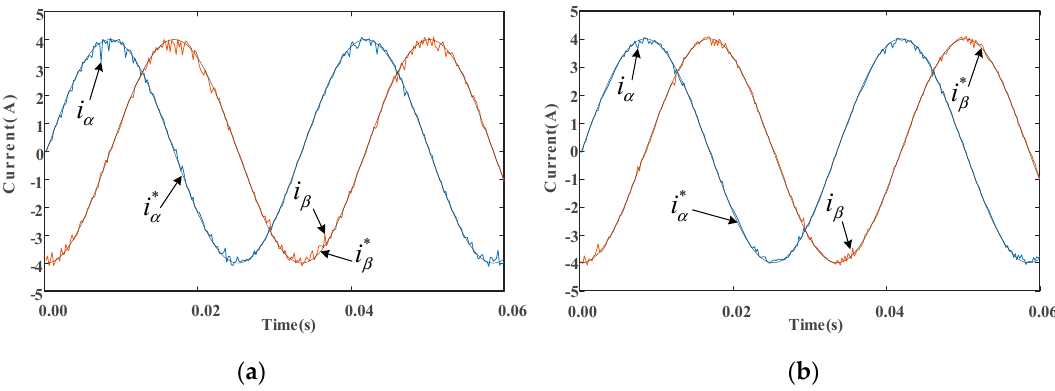
Figure 8. Trajectories of steady-state current under command 4 A at 30 Hz: ( a ) MPCC without modulation; ( b ) the proposed MMPCC.